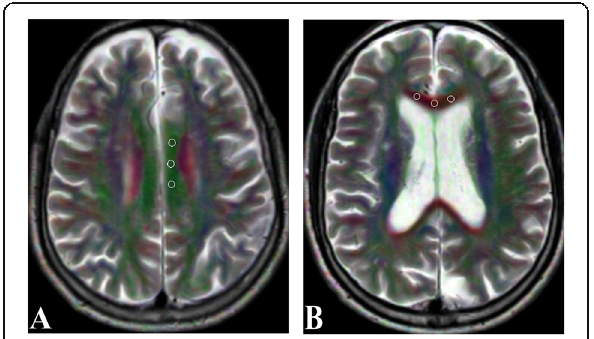
Fig. 3 Region of interest localization in patient with COPD: the FA map shows region of interest localization within the left cingulum ( a ) and genu of corpus callosum ( b ). The FA is 0.34 and 0.52, respectively, and the MD is (1.17 ± 0.13) and (0.99 ± 0.11) × 10 − 3 mm 2 /s of both